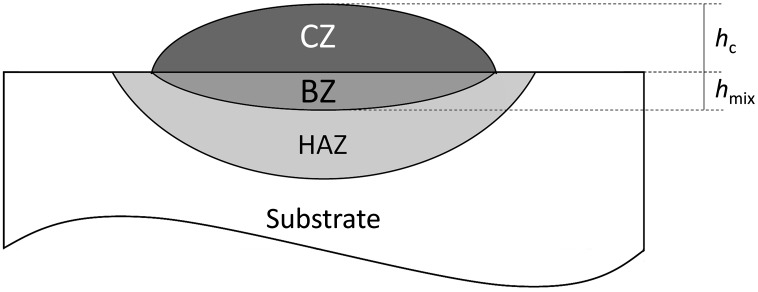
Clad dimensional characteristics and featured zones: cladding zone (CZ), bonding zone (BZ) and heat-affected zone (HAZ).